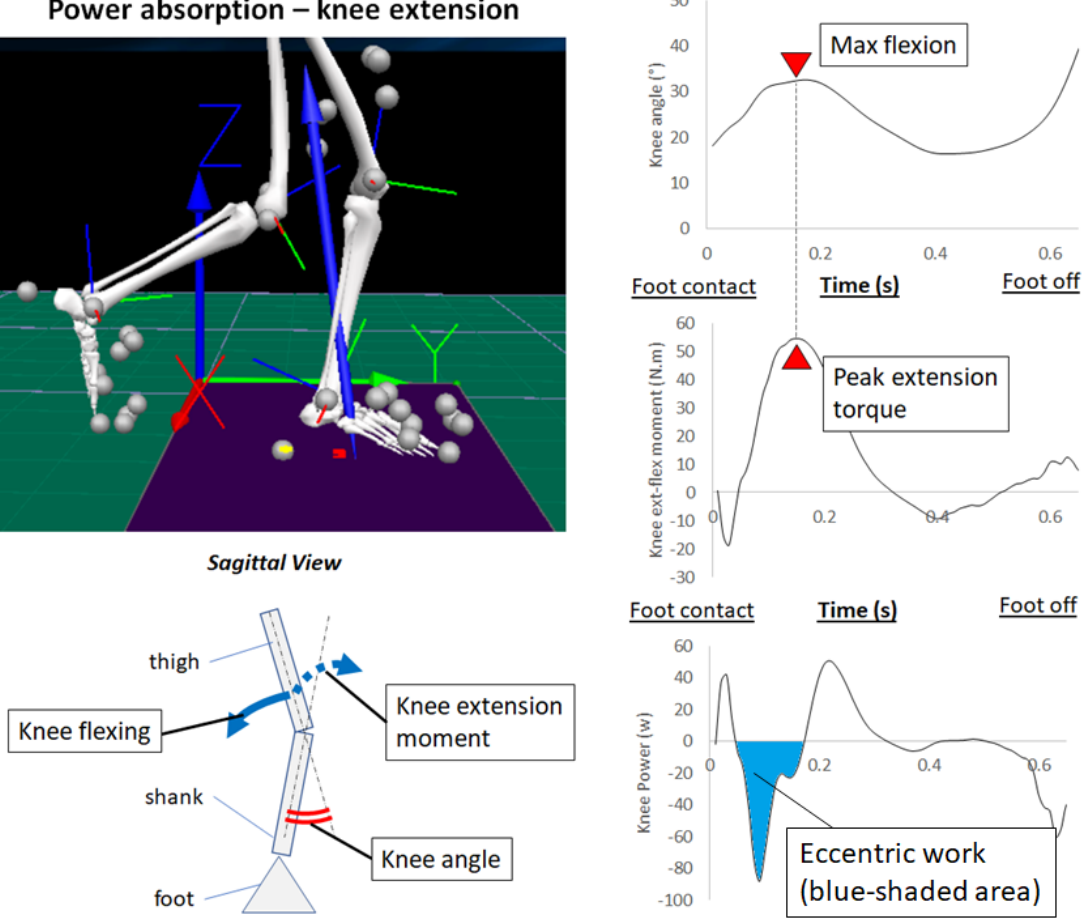
Figure 2. Sagittal plane knee kinetics. ( Top right ): Knee joint angle during stance phase. ( Middle right ): Knee extension torque. ( Bottom right ): Power absorption and eccentric work.